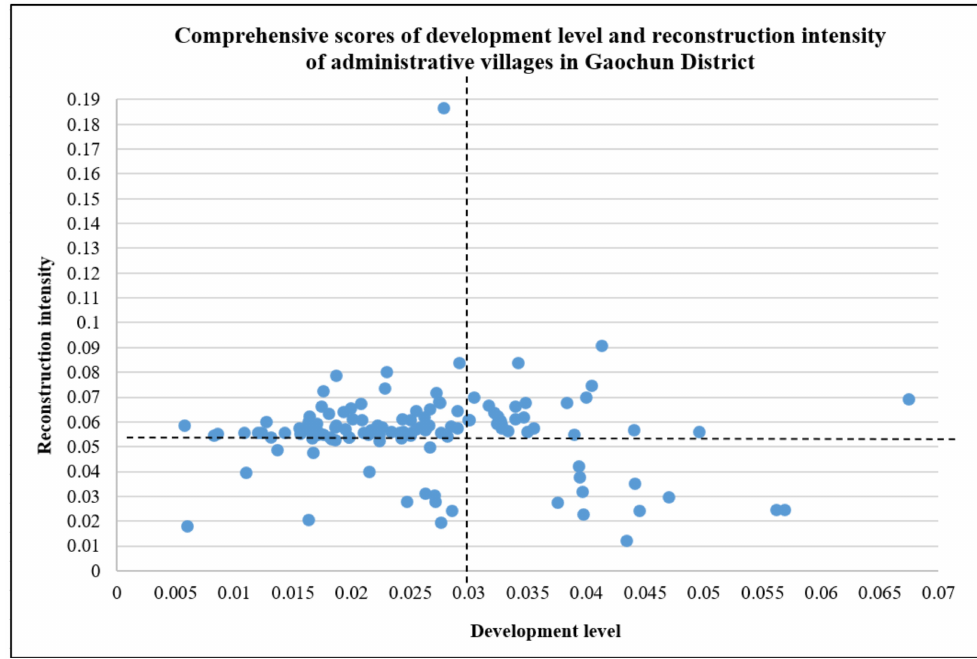
Figure 4. Scatter plot of comprehensive scores of development level and reconstruction intensity of administrative villages in Gaochun